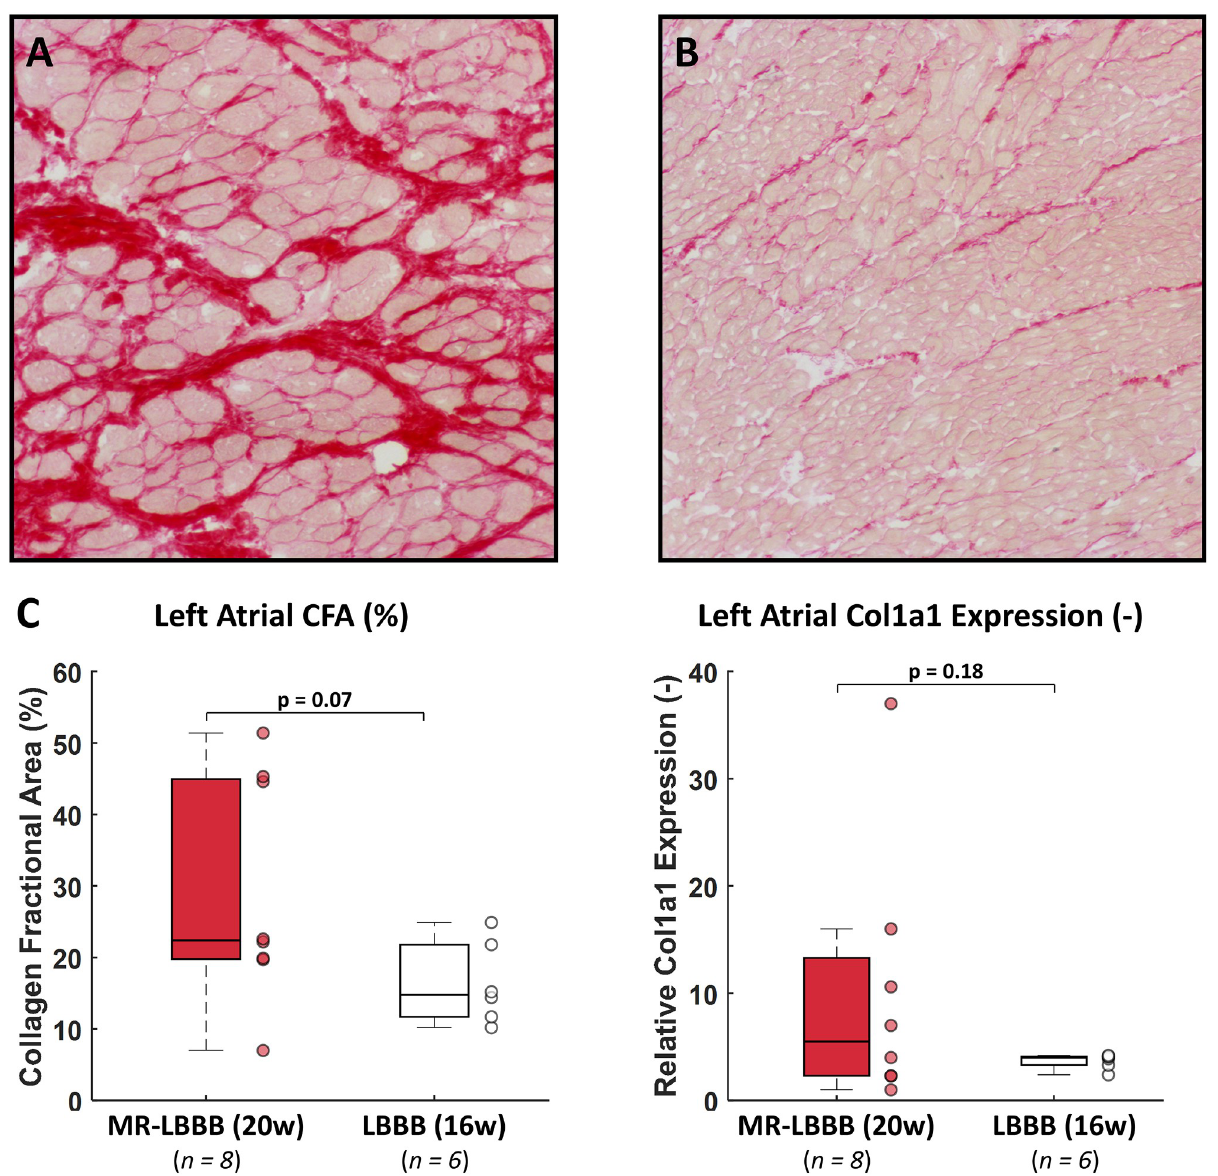
Fig 4. Histological and gene expression analysis of LA tissue. Representative examples of 0.1% Sirius Red stained LA tissue sections of the (A) MR-LBBB group and (B) LBBB group at 200x magnification. (C) Comparison of collagen fractional area (CFA) and relative collagen type 1 (Col1a1) expression to Cyclophilin-A for each group (presented as boxplots and scatters for individual animals). A trend towards more interstitial fibrosis and increased Col1a1 expression was found in the MR-LBBB group at 20 weeks, as compared to LBBB group at 16 weeks.